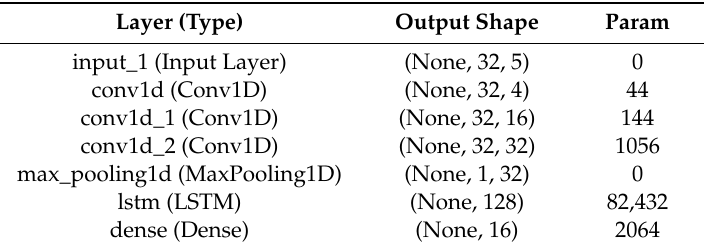
Table 1. The structure of the CNN–LSTM